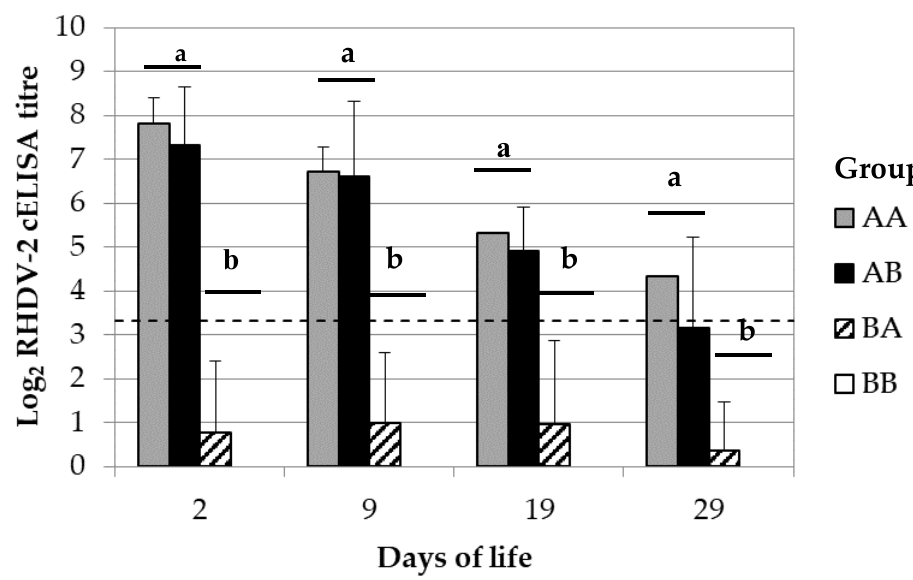
Figure 4. Mechanism of RHDV-2 antibody transmission from breeding does to rabbit kittens. Results are represented as average and standard deviation of Log 2 cELISA titres. The rabbit kittens were cross fostered between ERAVAC ® (AA), PBS vaccinated breeding does (BB) or between them (AB, BA). The slashed line indicates the cut-off of the assay (3.32 Log 2 cELISA titre). Different letters indicate statistically significant difference between groups (Kruskal Wallis test p < 0.05).